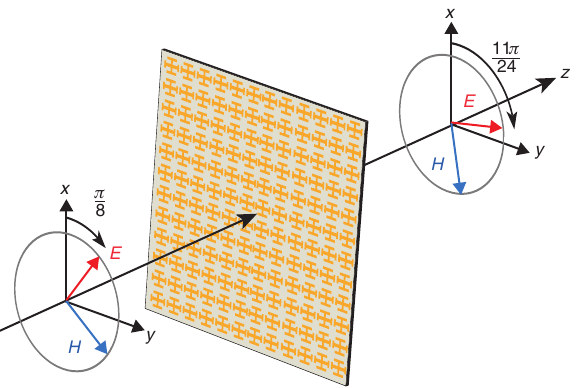
Figure 3: Polarization reflectionless rotating metasurface. The metasurface rotates the polarization of a linearly polarized normally incident plane wave from the angle π /8 to the angle 11 π /24 with respect to the x -axis (rotation of π /3). The metasurface is surrounded on both sides by vacuum, i.e. η